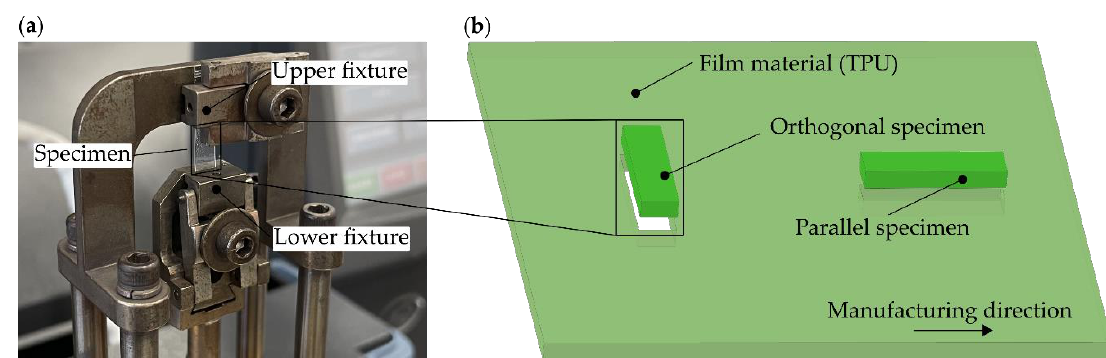
Figure 1. ( a ) Experimental setup of the DMA test in tensile mode, ( b ) schematic representation of the orthogonal and parallel removal of the film specimen with respect to the manufacturing direction of the film material.